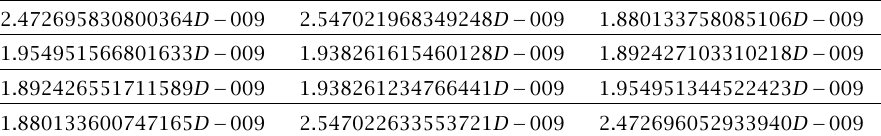
Table 3.16 . The errors with n = 12 , l = 0 . 25 on γ 0